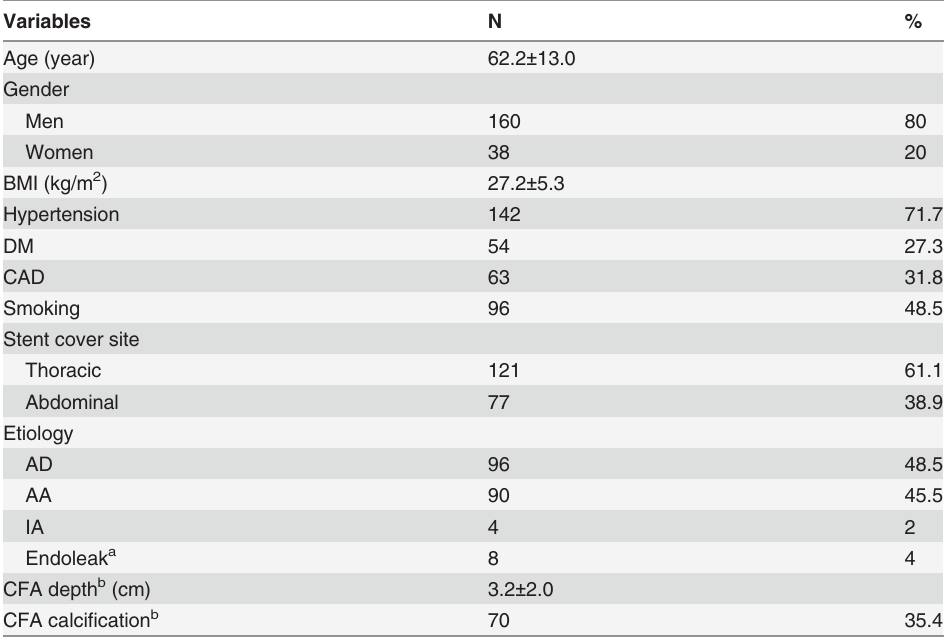
Table 1. Demographics characteristic of the